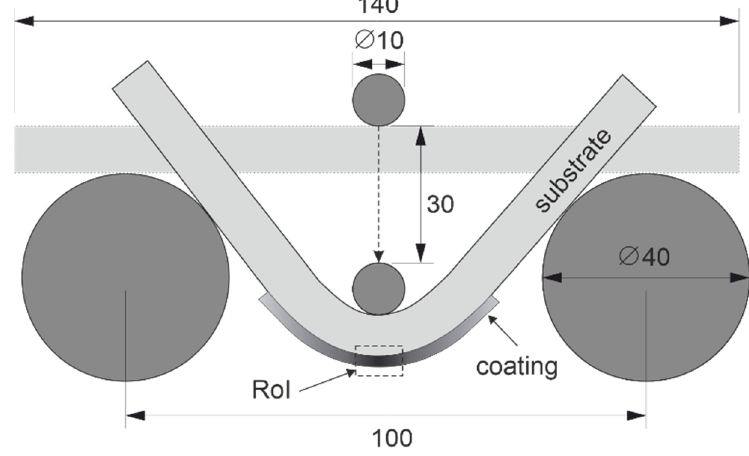
Figure 2. Experimental set up of 3-point bending test, dimensions in mm. The maximum displacement of the middle stamp was set to 30 mm. According to Equation (1), the calculated maximum flexural strain ( ε f ) in the outer surface of the coating at the maximum deflection is about 20%.